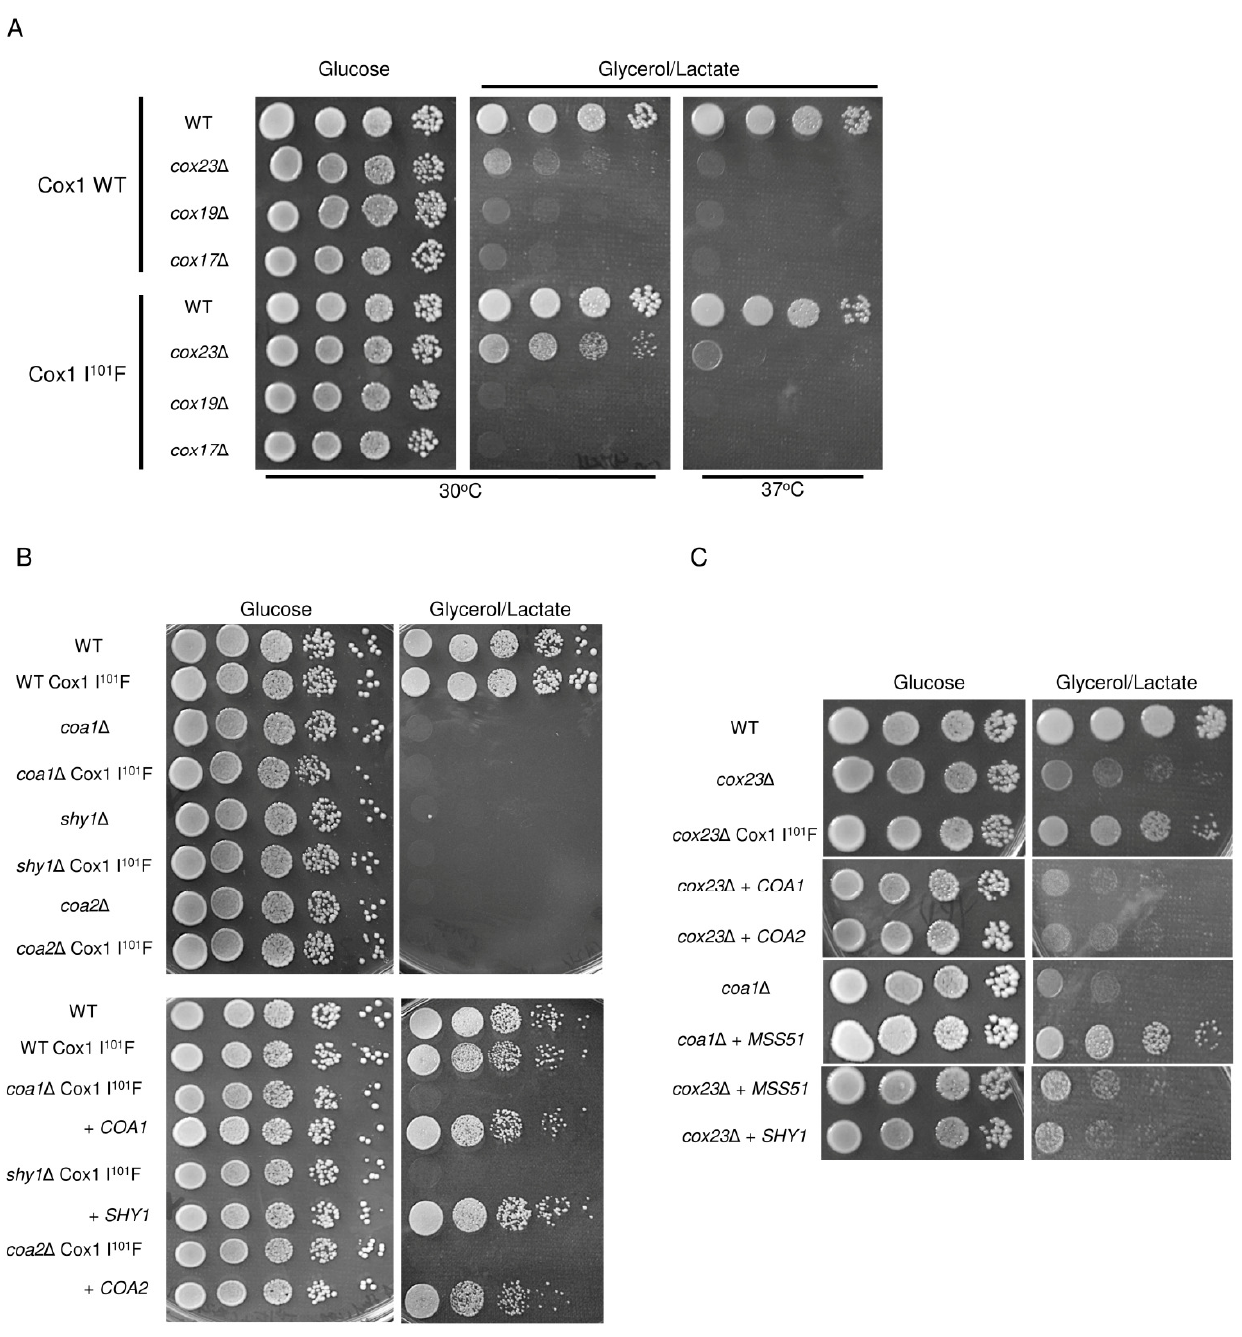
OPEN ACCESS | www.microbialcell.com 280